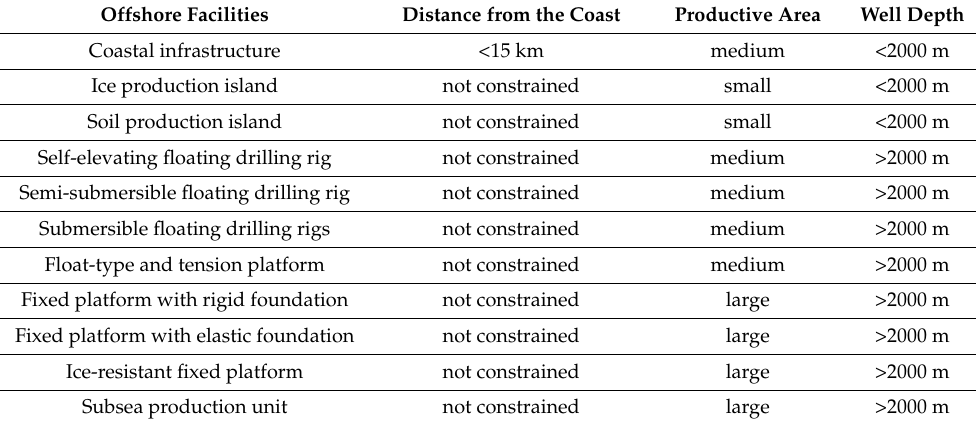
Table 1. The applicability analysis of offshore oil and gas facilities (technological factor)